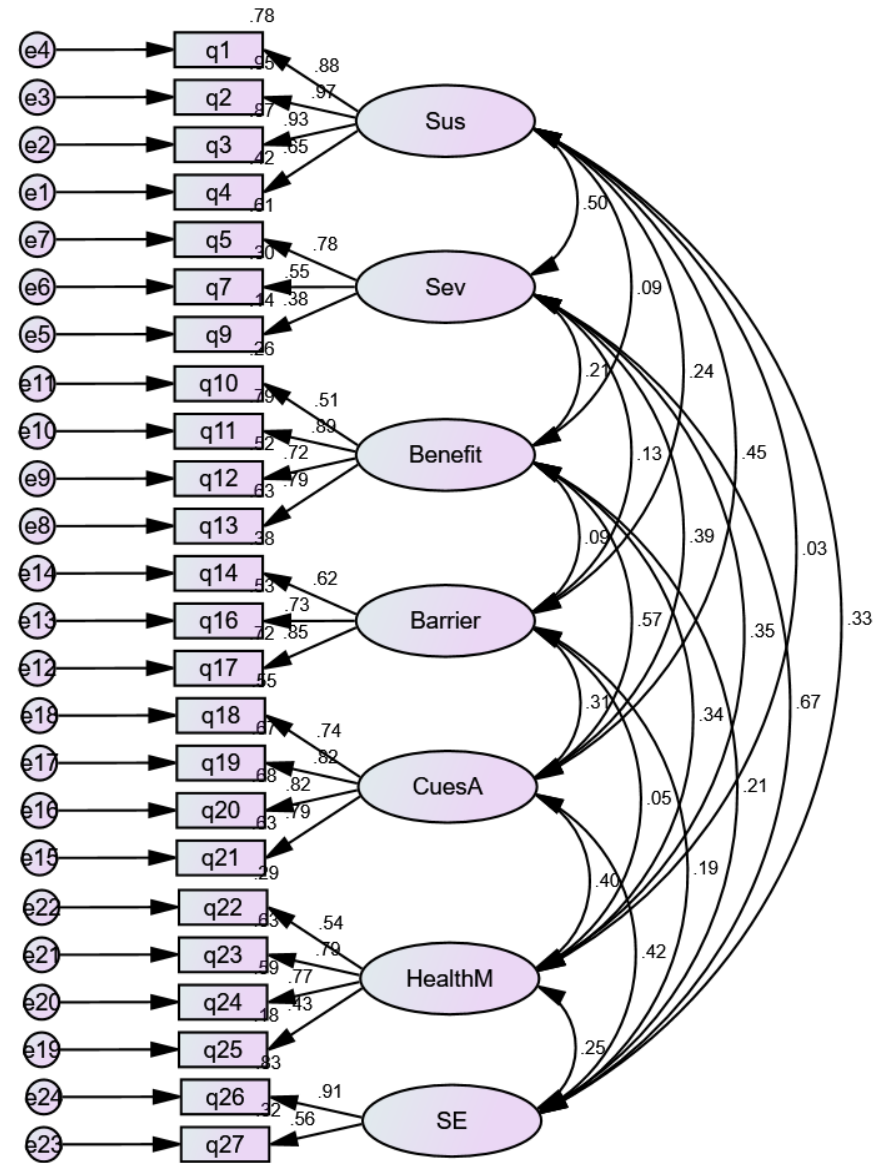
Figure 1. CFA model with 24 items. Sus (perceived susceptibility), Sev (perceived severity), Benefit (perceived benefits), Barrier (perceived barriers), CuesA (cues to action), HealthM (general health motivation), SE (self-efficacy). Table 5. Confirmatory Factor Analysis report.